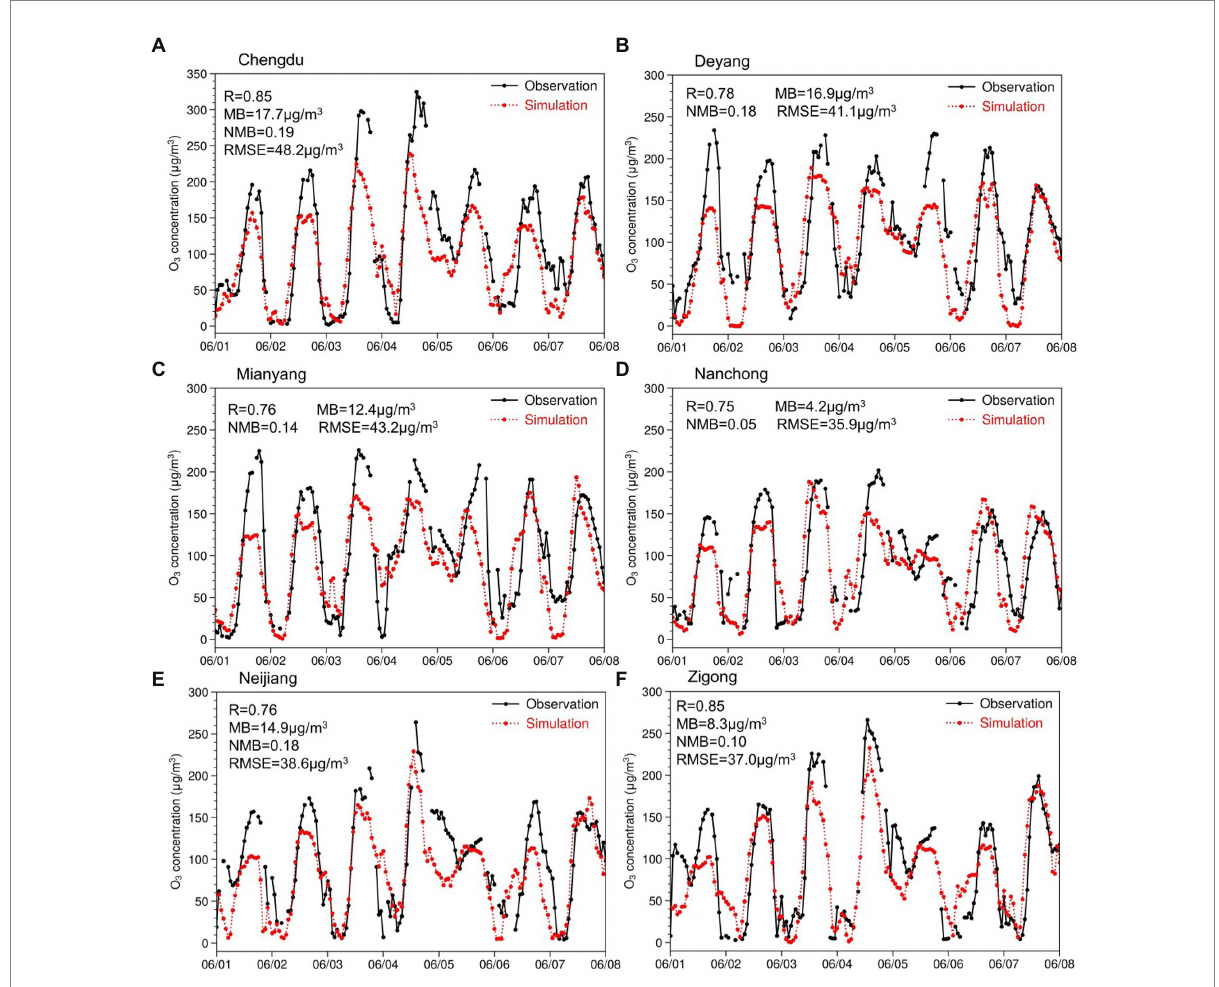
FIGURE 2 Time series of observed and simulated surface O 3 concentrations at (a) Chengdu, (b) Deyang, (c) Mianyang, (d) Nanchong, (e) Neijiang, and (f) Zigong cities from June 1 to 8,